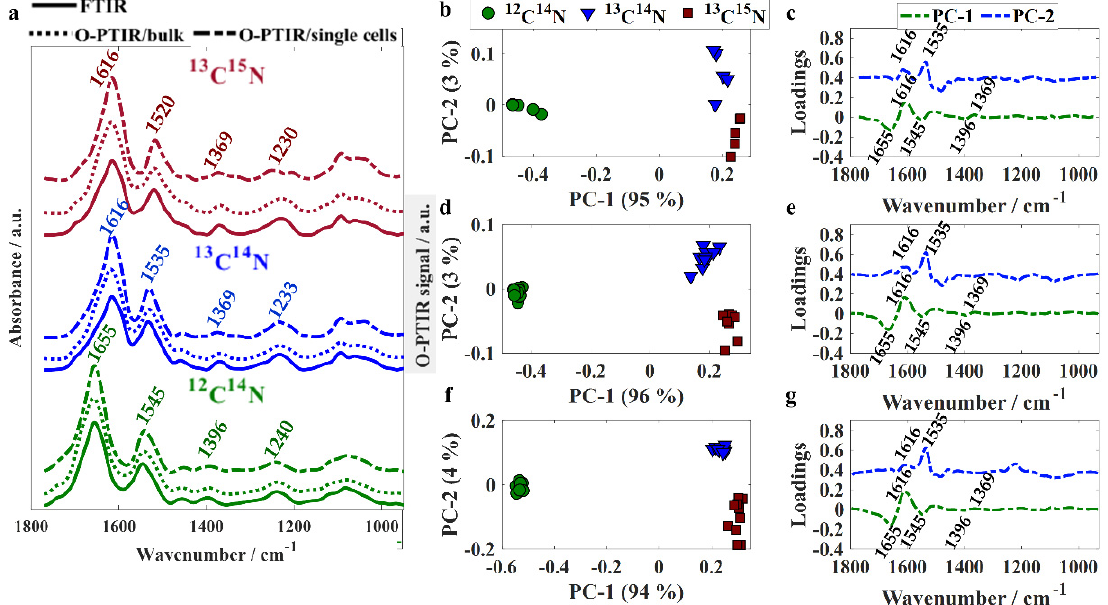
Figure 1. ( a ) Fingerprint region of averaged spectra collected via FITR, O-PTIR/bulk, and O- PTIR/single cells acquired from E. coli cells incubated with 12 C 14 N (green line), 13 C 14 N (blue line), and 13 C 15 N (red line). Plots are offset for clarity. PCA scores and loadings plots obtained using FTIR ( b , c ), O-PTIR/bulk ( d , e ), and O-PTIR/single cells ( f , g ) as input data; values in parentheses are the percentage of total explained variance (TEV).